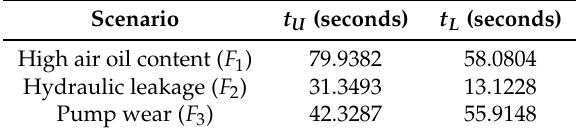
Table 2. Time estimation of the first detection by using the residual signals (13).